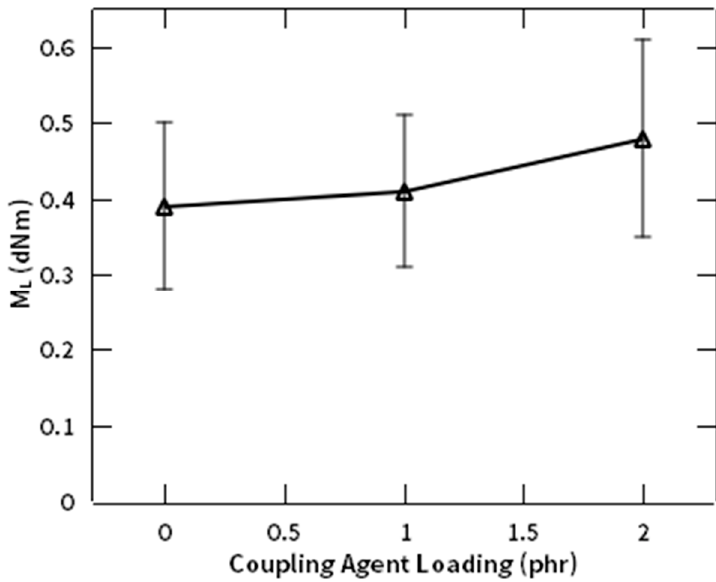
Figure 8. M L profile of NR compound at different composition of NR-g-St.